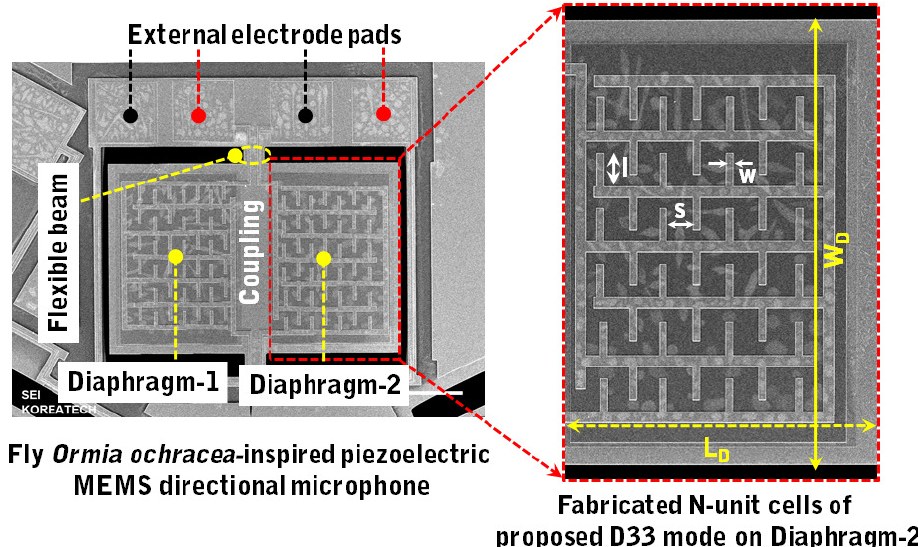
Figure 7. Scanning electron microscope (SEM) image of the fabricated bio-inspired piezoelectric MEMS directional microphone, where L D and W D are each individual diaphragm’s length (880 µ m) and width (1200 µ m), respectively. The inset shows the zoomed view of a single span of the proposed D33 mode, where s, w and l are the spacing (68 µ m), width (20 µ m), and length (90 µ m) of IDT,